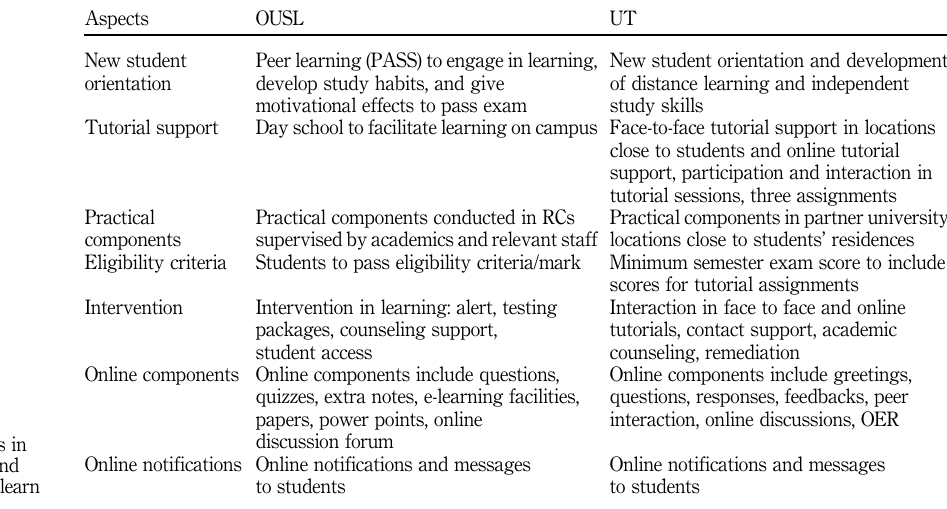
Table 10. Good practices in engagement and motivation to